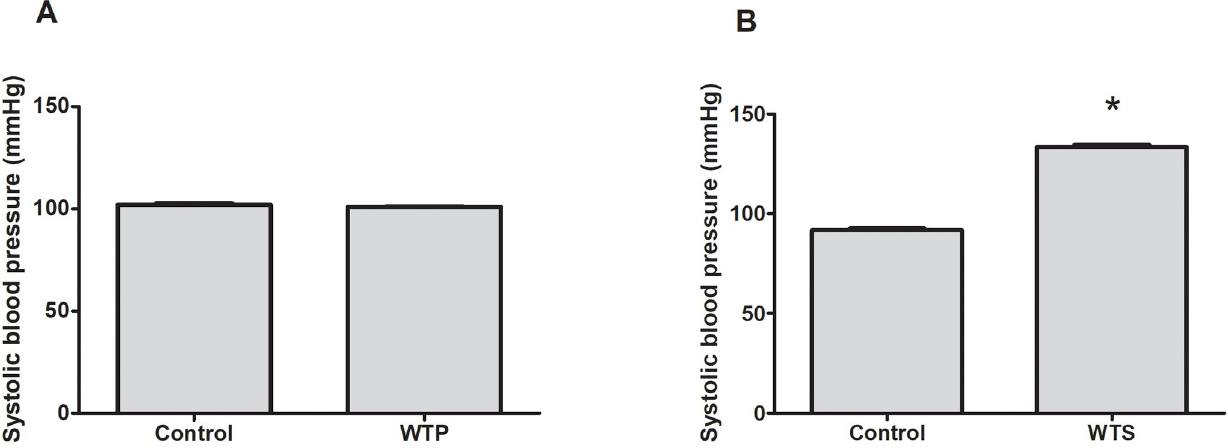
Fig 1. Effect of WTS on systolic blood pressure. Systolic blood pressure was measured at (A) baseline and (B) after exposure to fresh air or WTS for 19 weeks � indicates significant difference from control. Values are expressed as mean ± SEM of 8 animals per group. P < 0.05 was considered statistically